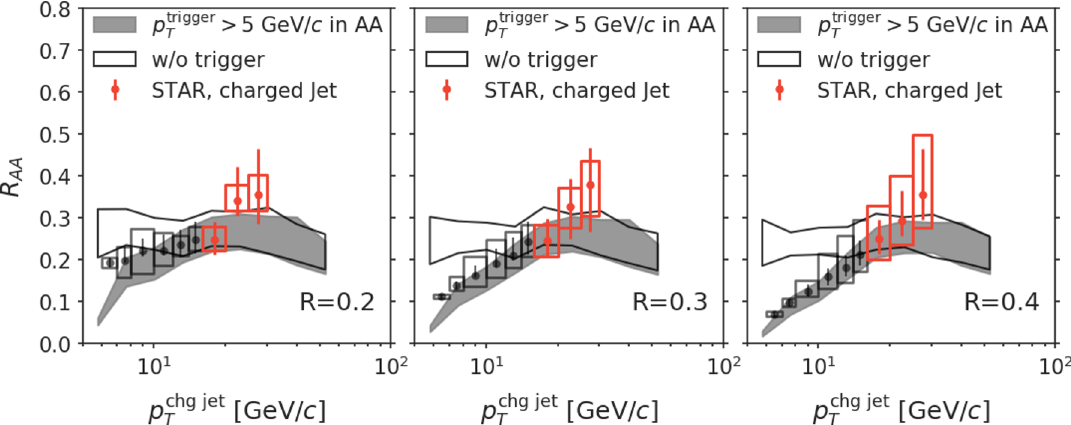
Figure 13 . Predictions of cone-size dependence of inclusive jet nuclear modification factor in √ Au-Au collisions at s NN = 200 GeV, compared to charged-jet measurement from the STAR ex- periment [92]. The experimental data colored in red (the three highest p chg jet considered to be “unbiased”, while the rest of the data points shown in black are subject to a strong bias due to the trigger on the leading